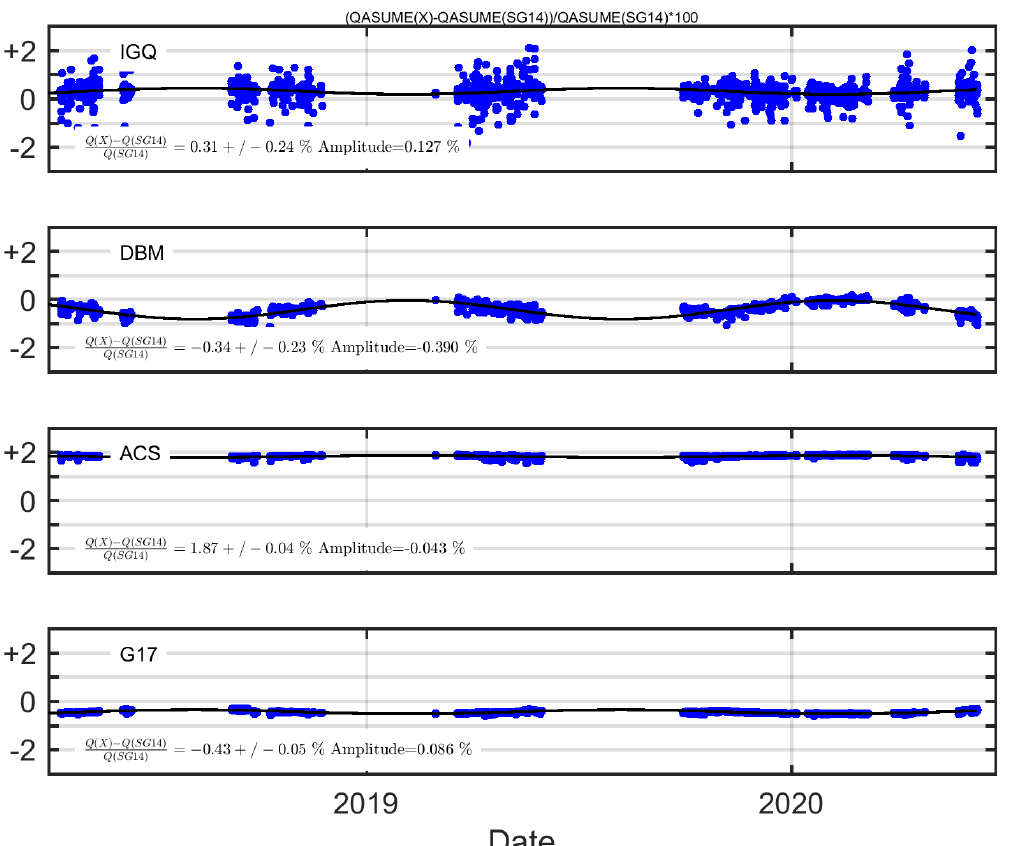
Figure 2. Differences (%) of systematic offset, point to point variability ( ± ) and seasonal variation (amplitude) of TCO retrieval of different cross sections compared with the SG14 standard cross